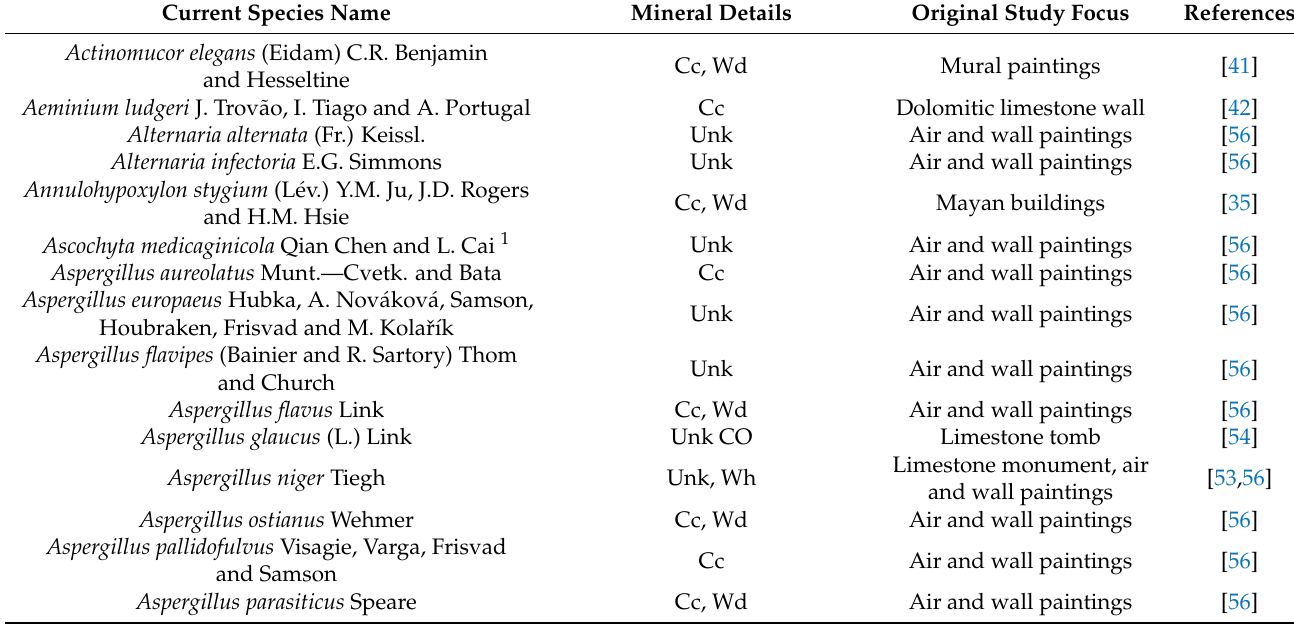
Table 2. Overview of fungal species for which isolates have been identified as displaying mineralization abilities in biodeteriorative plate